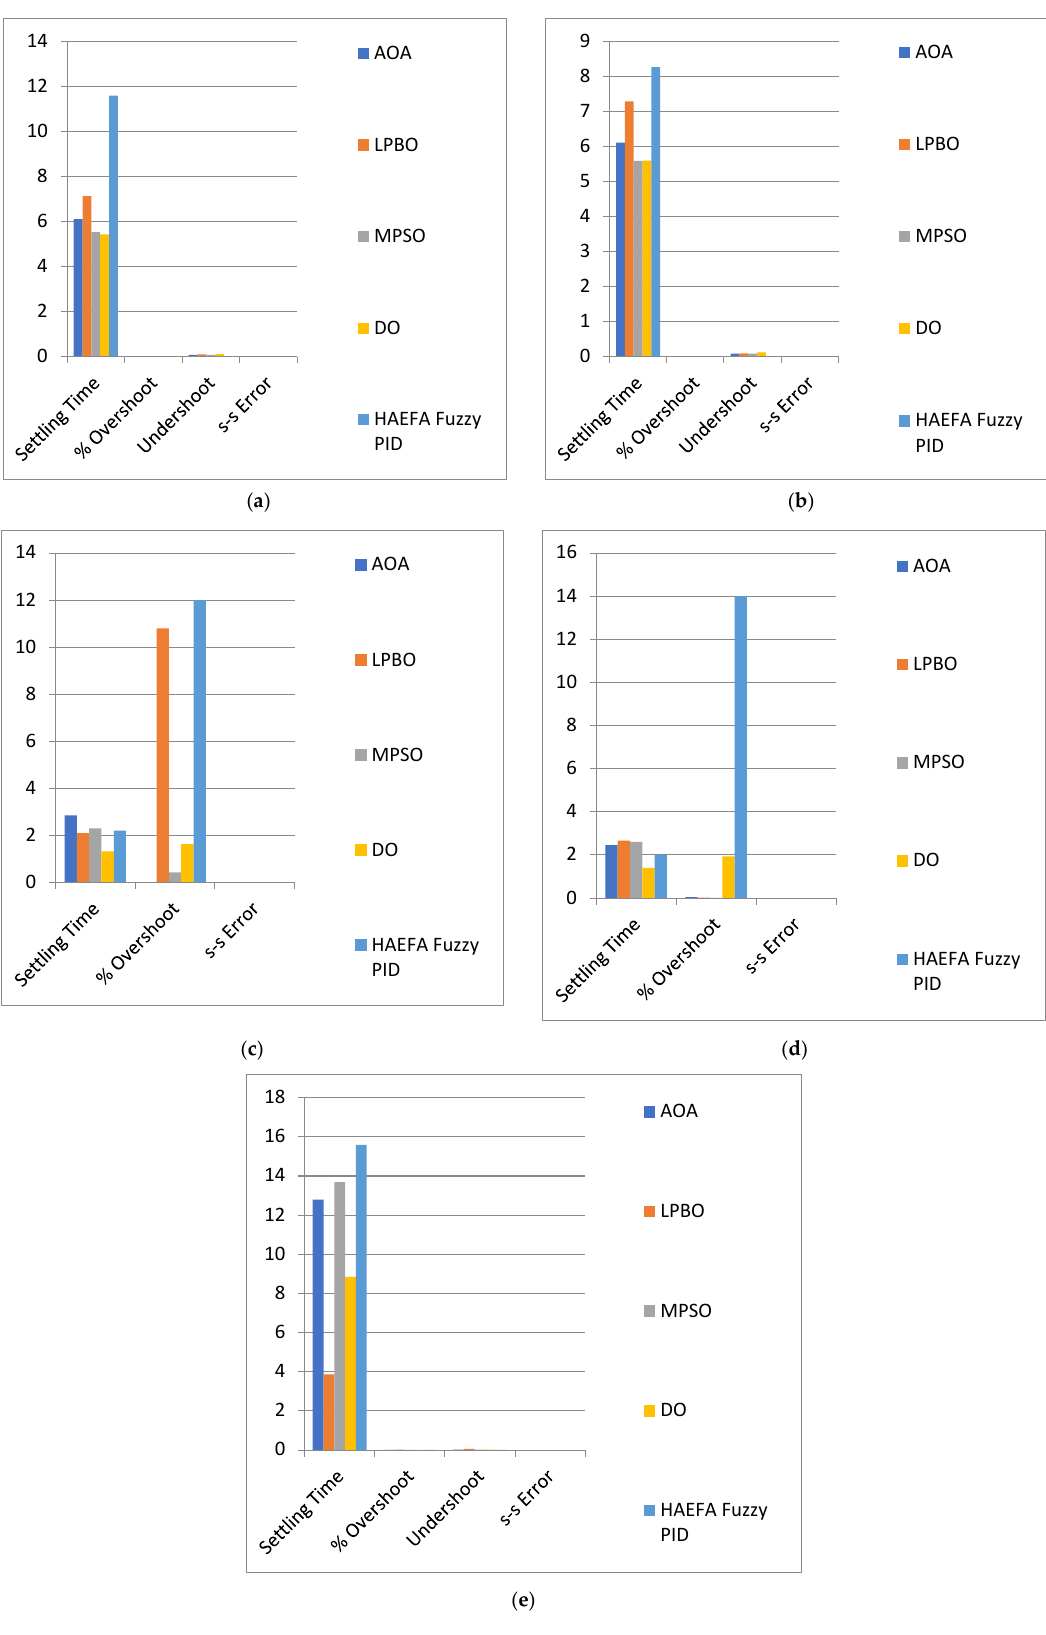
∆ f 1 ; ( b ) 2 ; ( c ) V t1 ; ( d ) V t2 ;